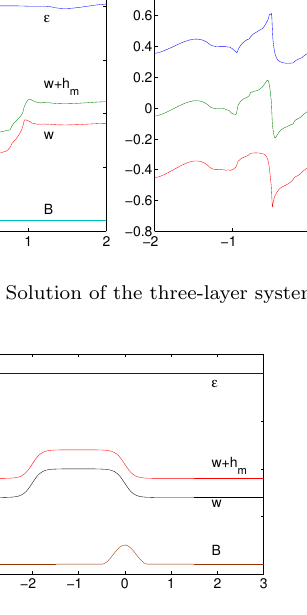
Figure 7. Example 2: The initial setting for the three-layer system with (cid:98) h m = 0 .